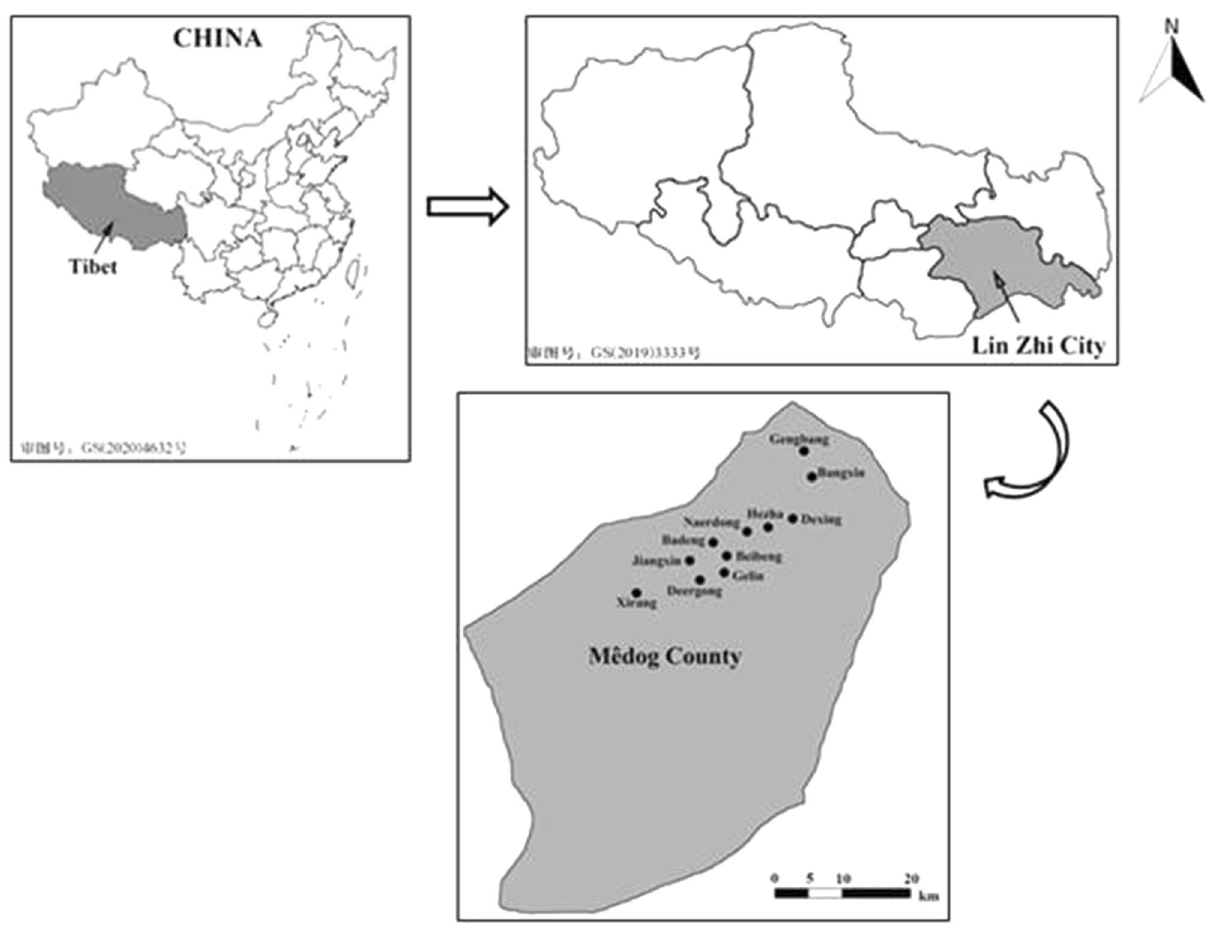
Figure 1. The location of 11 study villages in Mêdog County, Lin Zhi City, Tibet,